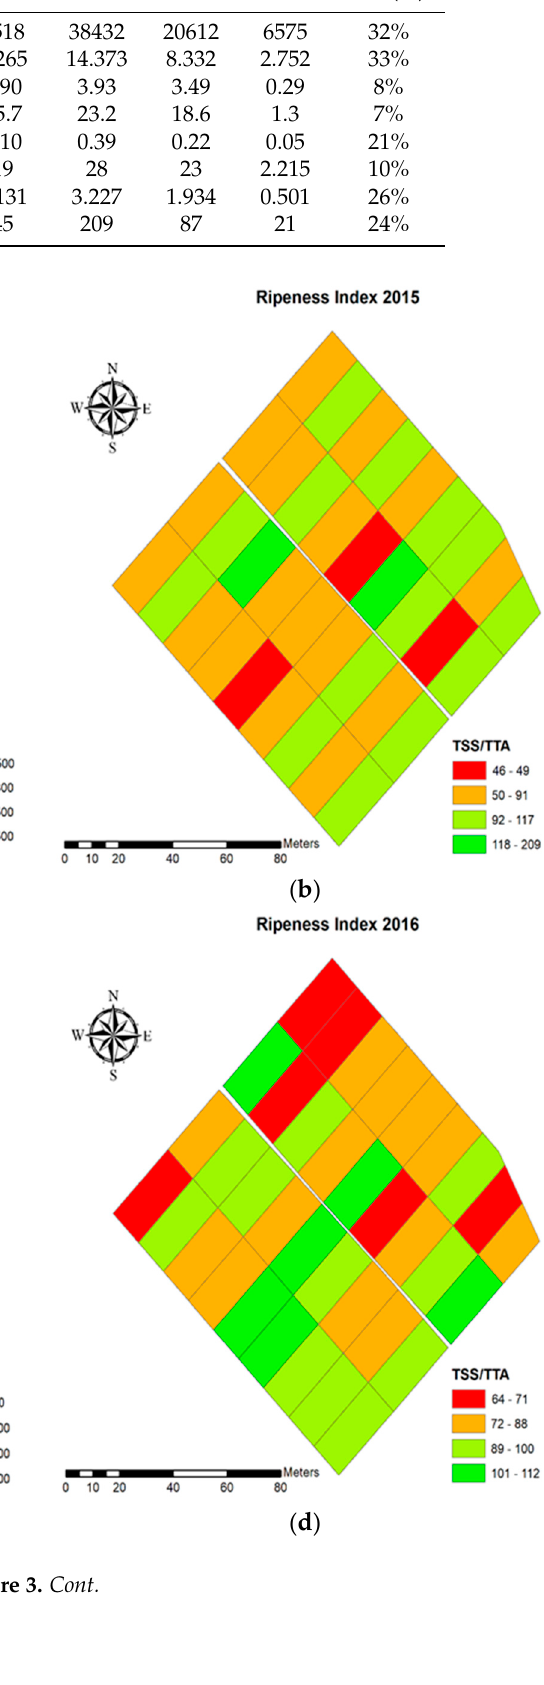
Table 3. Descriptive statistics of the yield and quality characteristics of table grapes for the three years. Table Grape Parameters